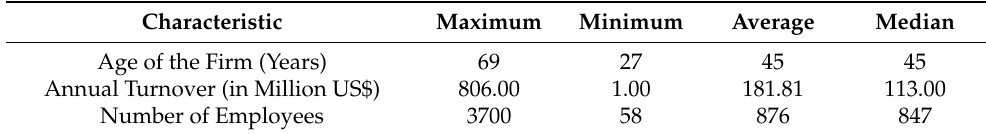
Table 2. Respondent Characteristics.